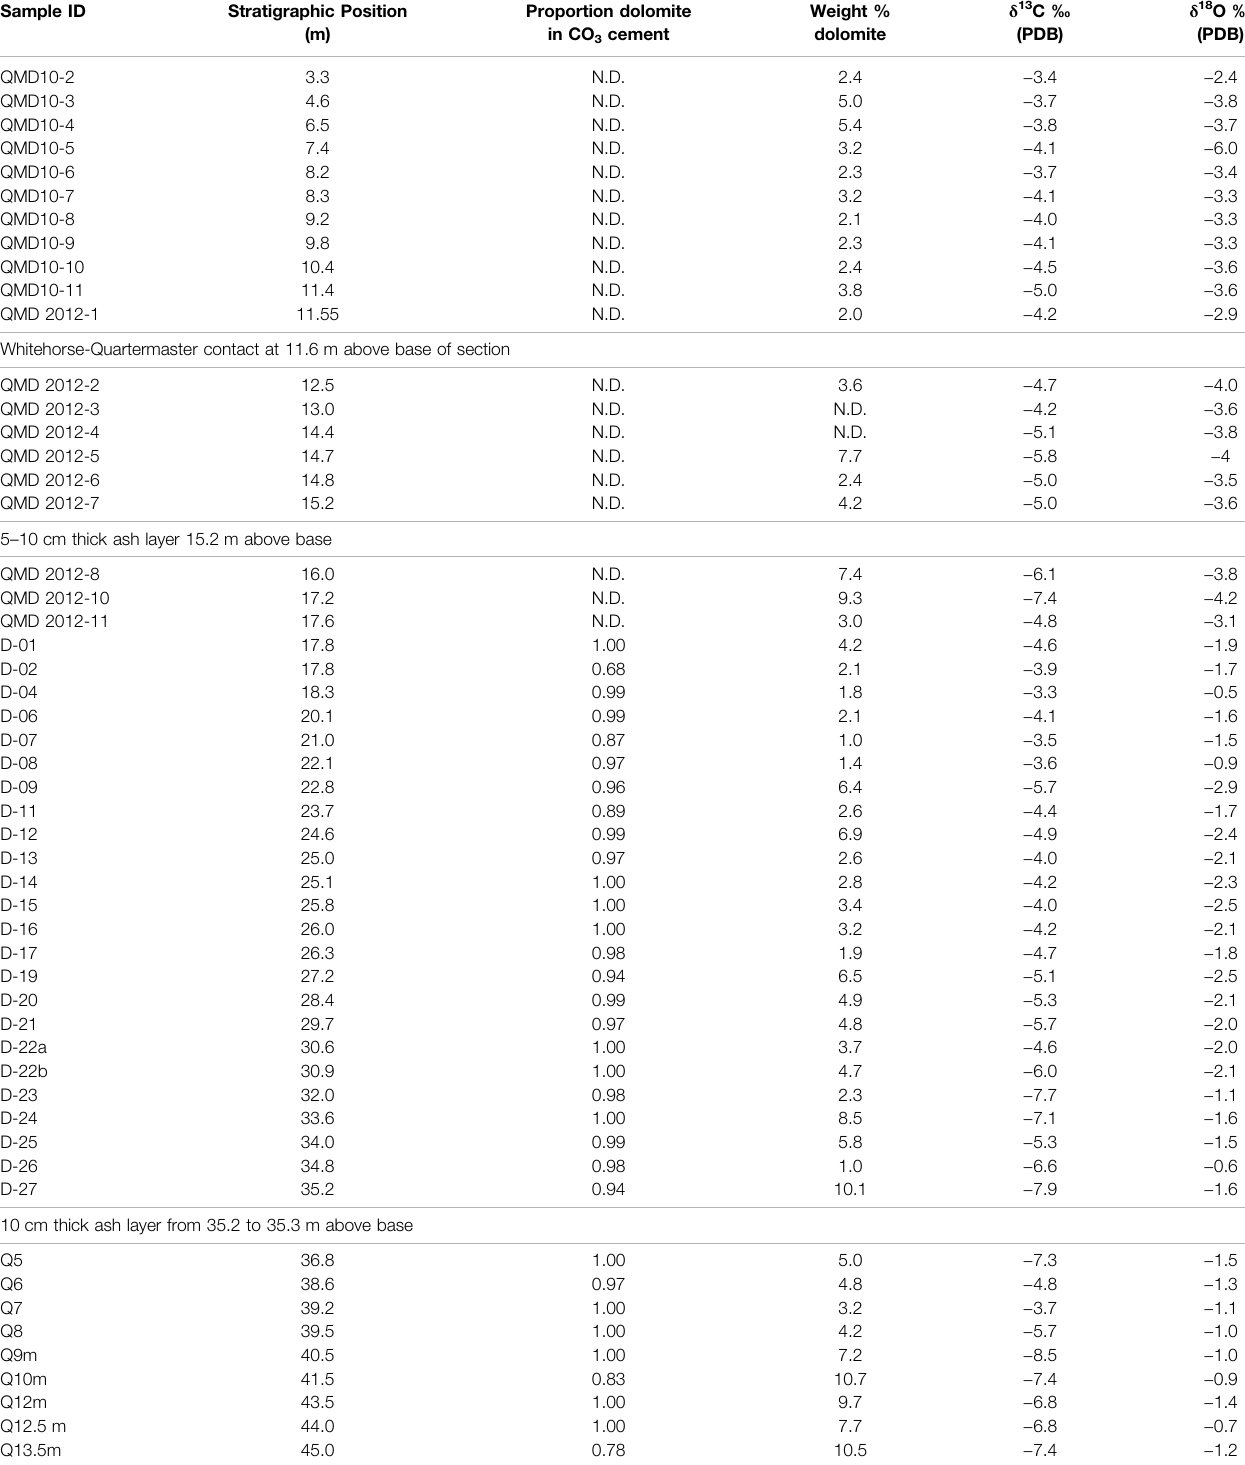
TABLE 10 | Results of analysis of dolomite cements from